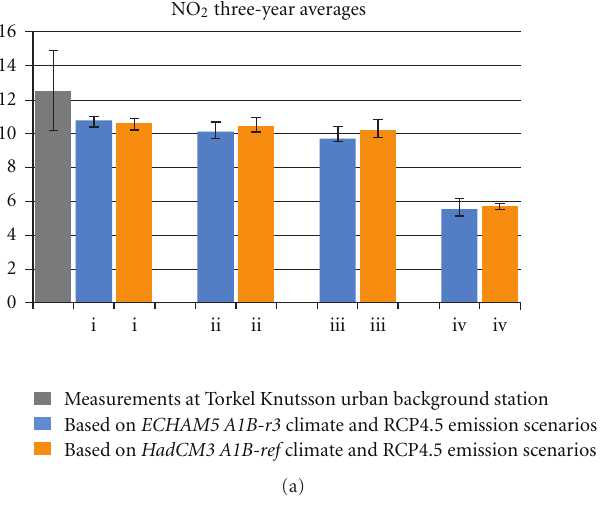
Figure 6: Observed and simulated levels of NO 2 diurnal mean (a) and 98-percentile of hourly levels (b) at Torkel Knutssonsgatan (city centre of Stockholm), for present conditions (i) and simulated projections of future levels with only climate change e ff ect (ii), including also emission changes in Europe (iii) and adding local emission changes in Stockholm (iv), see Table 2 for explanations. Error bars indicate lowest and highest annual average value of the three years. Unit: µ gm − 3 . Simulated concentrations are bilinearly interpolated to the location of the monitor location. Table 2: Model simulations performed for the large metropolitan area with 2 × 2km 2 spatial resolution. Present and future meteorology represent 3 full years centered around 2010 and 2030, receptively. Data generated by the RCA3 model forced with ECHAM5 A1B-r3 and HadCM3 A1B-ref on the